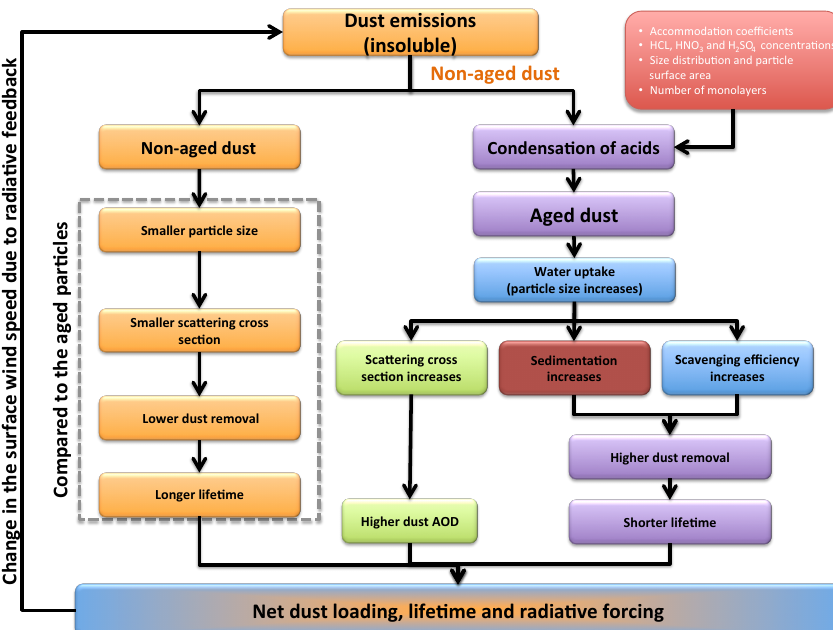
Figure 1. A schematic representation of the dust cycle and the feedback from air pollution, dust, chemical aging and radiation in EMAC. Air pollution controls the chemical aging of dust particles, whereby the consequent water uptake increases the dust particle scattering cross section and enhances the dust deposition (wet and dry), which tends to decrease the dust lifetime. The net radiative differences between aged and non-aged dust particles are